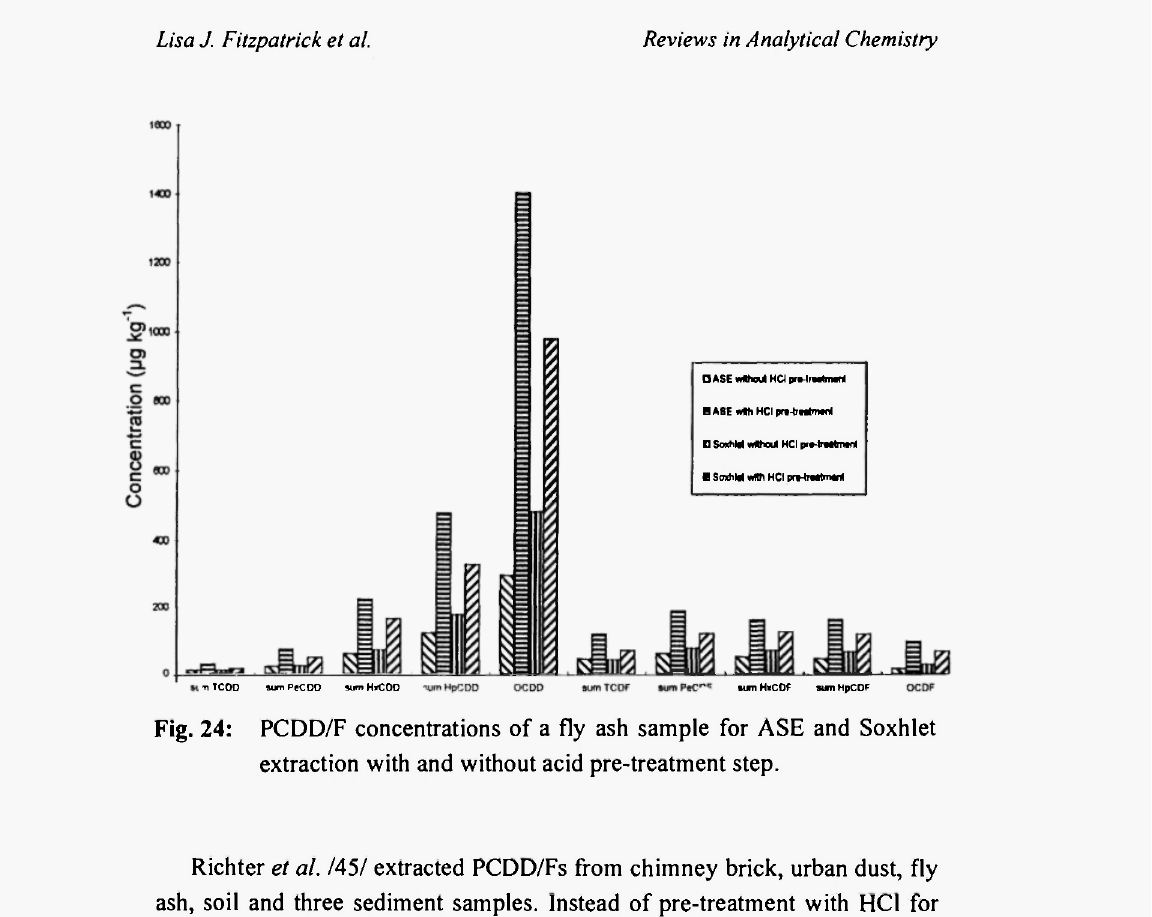
Fig. 24: PCDD/F concentrations of a fly ash sample for ASE and Soxhlet extraction with and without acid pre-treatment